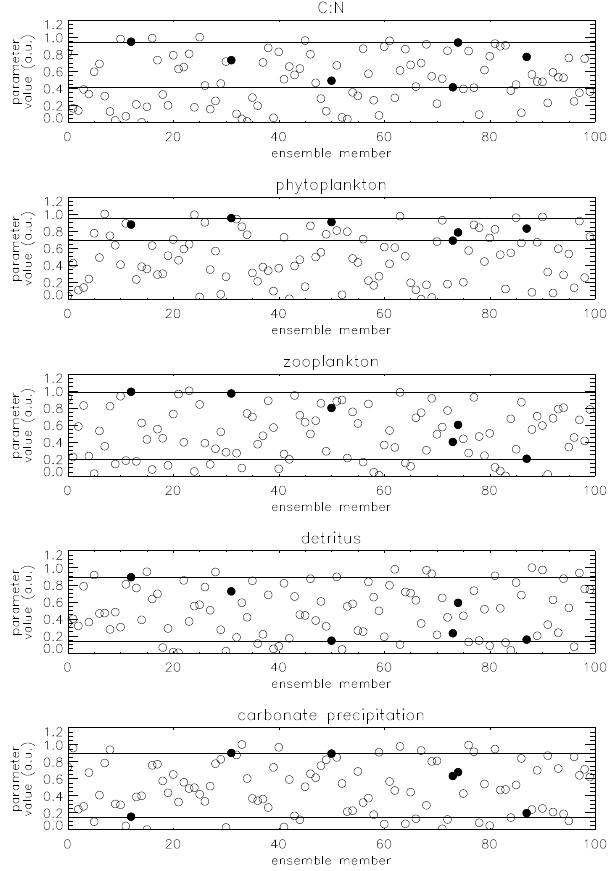
Fig. 8. The sensitivity of the ocean ensemble members to individual parameters. The top scoring six (in terms of their AMS) simulations are shown with filled symbols and the horizontal lines represent the minimum and maximum values of each parameter covered by